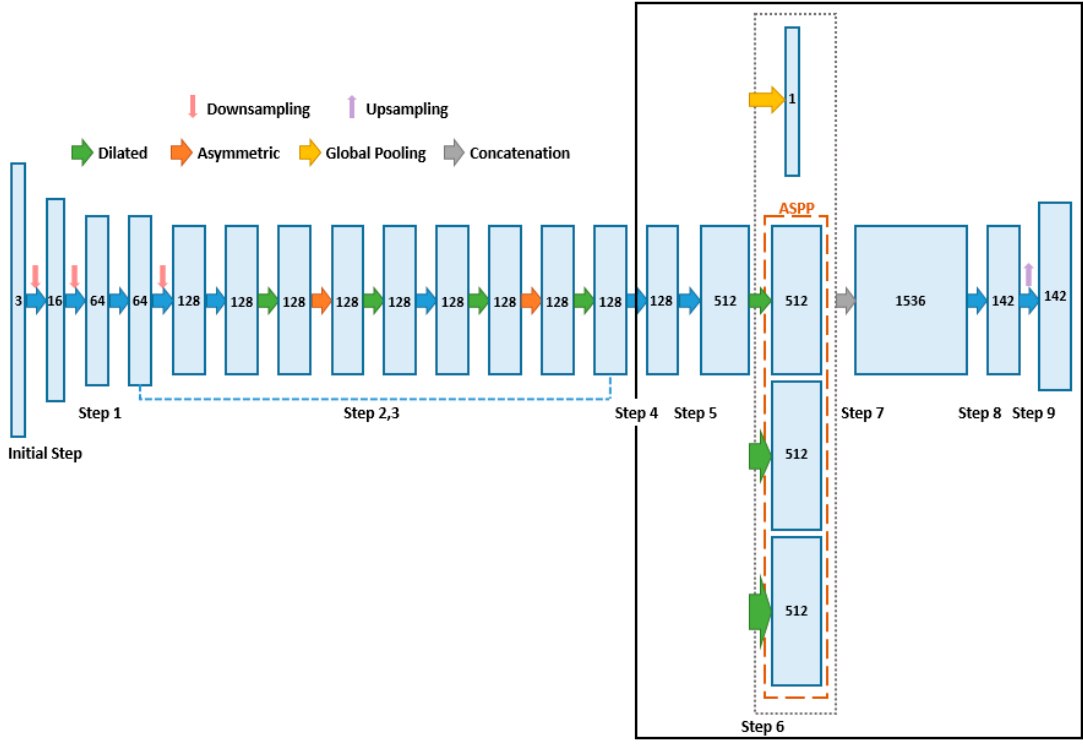
Figure 1. Lightweight efficient neural network architecture. The output size consists of three tuples: number of feature maps, width of a feature map and height of a feature map (142 × 513 × 385). The bold black line indicates the newly proposed network structure.